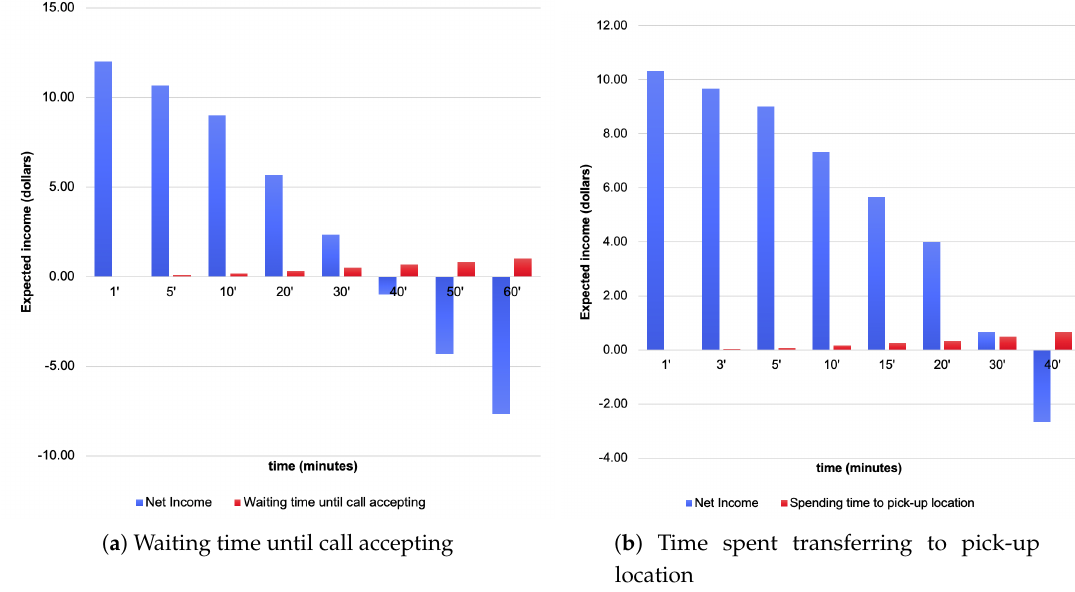
Figure 3. Simulation of the income to determine the preferred